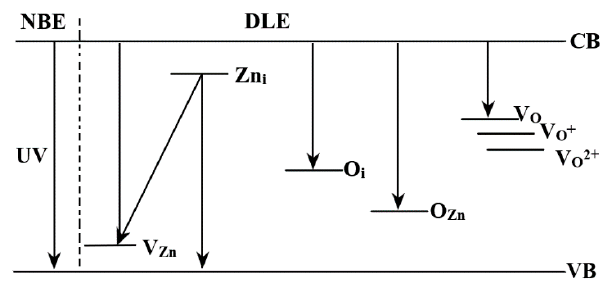
Figure 5. Defect’s levels in ZnO nanoparticles; the UV emission is referred to as Near Edge Band (NBE), while the visible emission is caused by Deep Level Emission (DLE).